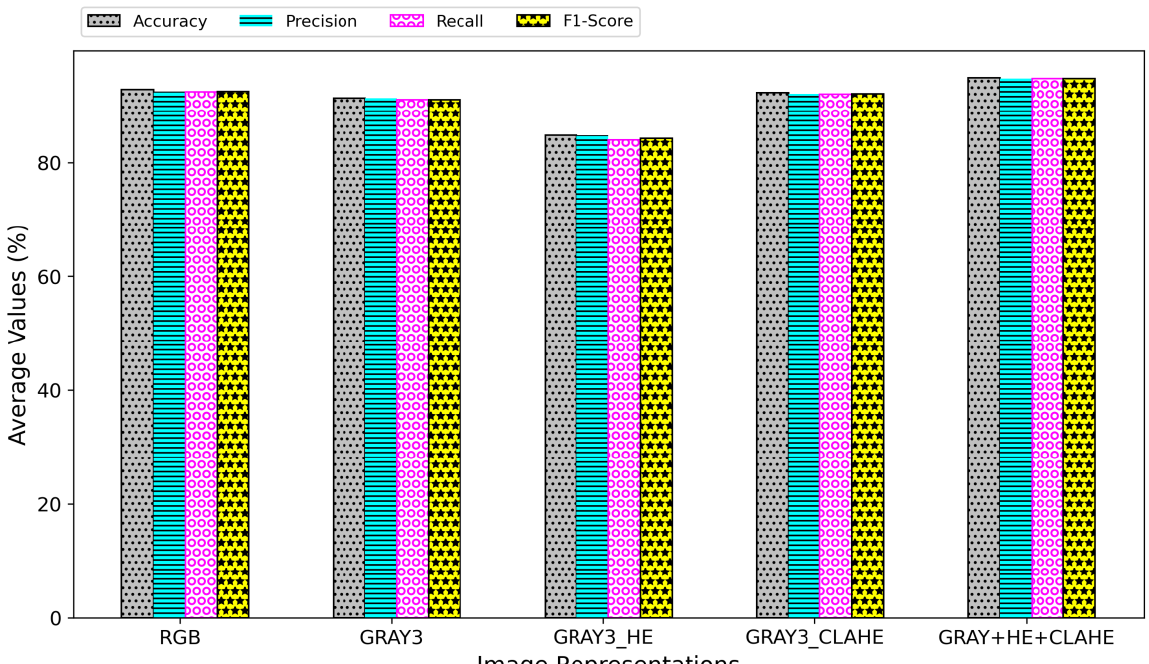
Figure 8. Average values of the models’ performance with respect to e ach image representation.